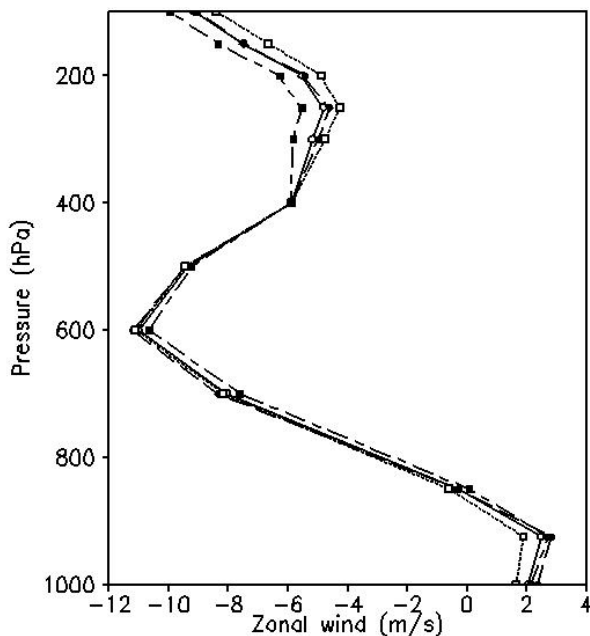
Fig. 2. Observed vertical profile of zonal wind in JJAS season aver- aged over the 1979–2005 period at the AEJ axis (15 ◦ N latitude) at longitudes 5 ◦ W (in long shot dash), 5 ◦ E (in shot dash) at Green- wich meridian (in long shot) and the mean values (in solid). Nega- tive value of zonal wind denote the easterly wind, whereas the pos- itive value is for westerly. AEJ is located here at 600hPa.